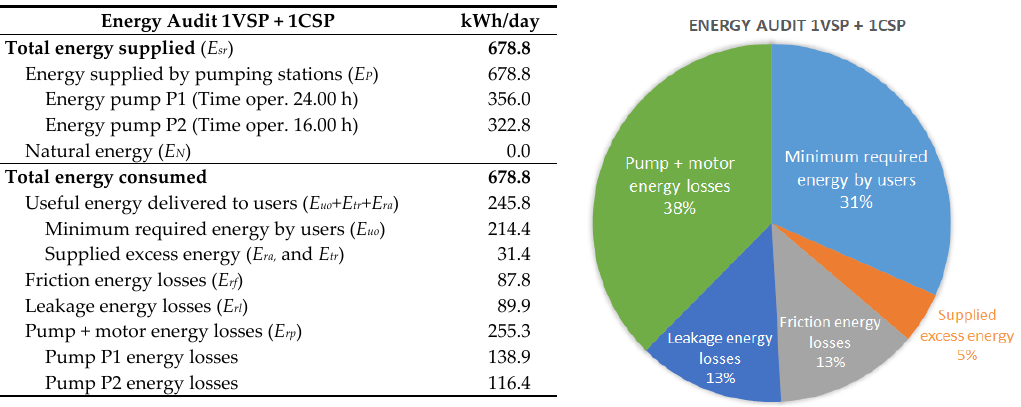
Figure 6. Energy audit result of the initial system with one constant speed pump (CSP) and one variable speed pump